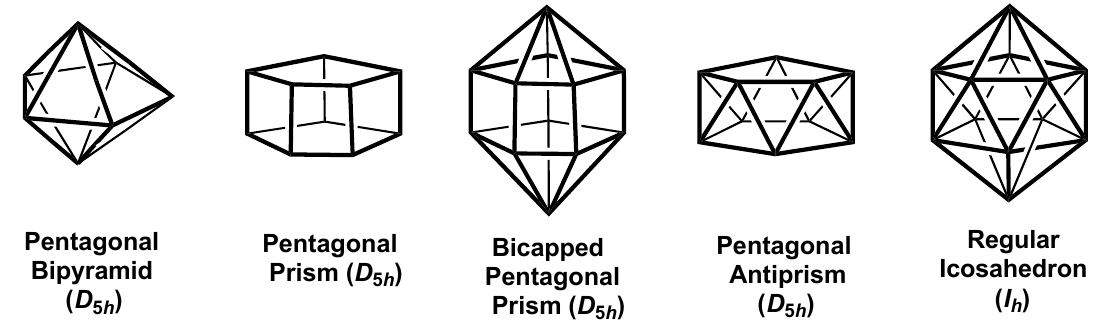
Figure 4. Pentagonal polyhedra with at least one C 5 rotation axis.